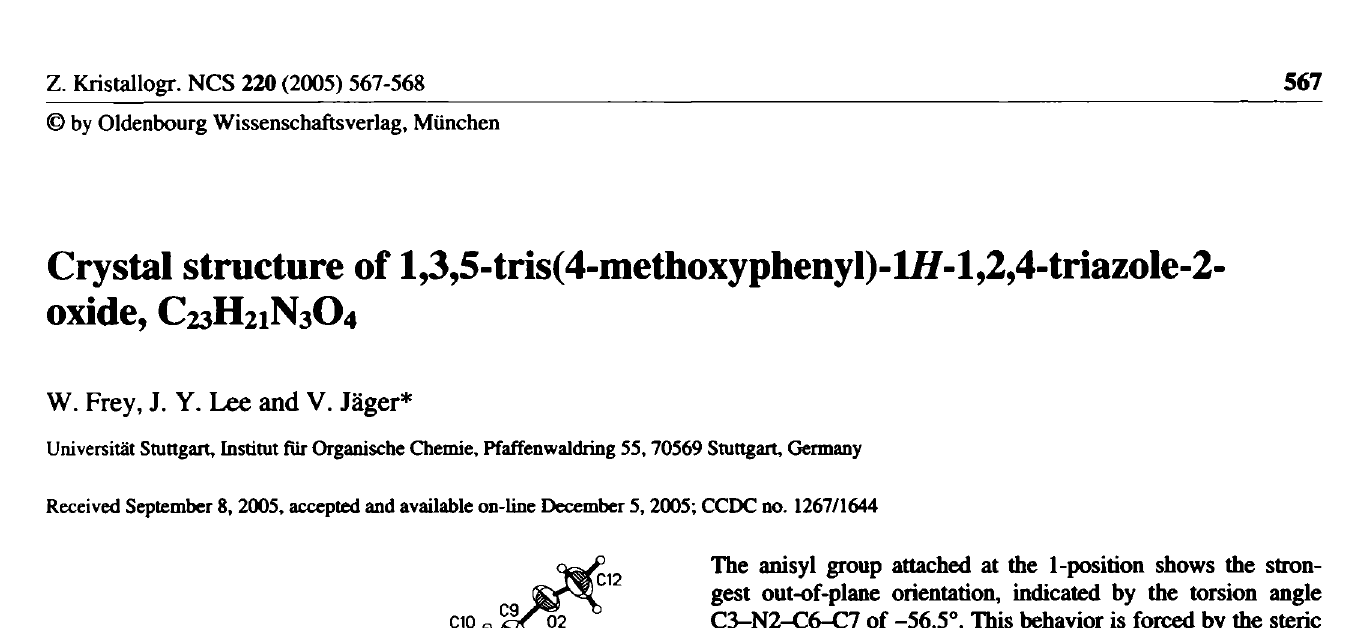
Table 1. Data collection and handling.